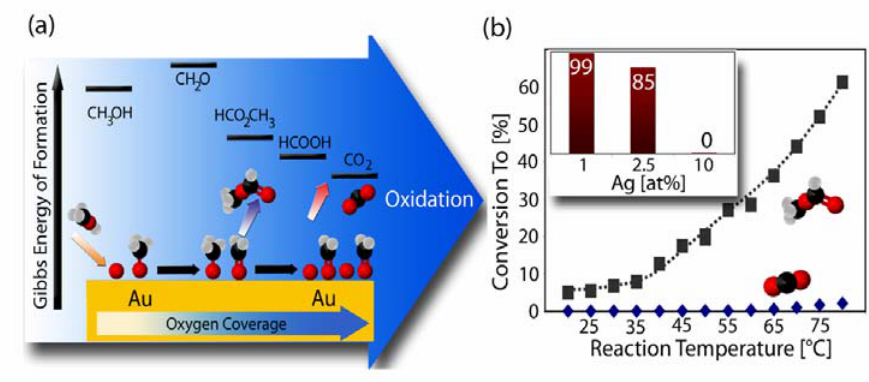
Figure 5. (a) Thermodynamics of oxidation of methanol. Total oxidation to CO thermodynamically favored, and selectivity thus requires desorption of desired intermediates prior to further oxidation. (b) Conversion of methanol to methyl formate (grey squares) and CO (blue diamonds) as a function of the reactor temperature (2 vol % 2 methanol + 1 vol % O ). Inset: The selectivity (percent) towards partial oxidation (methyl 2 formate at 80 °C) depends on the amount of residual Ag in np-Au. Reproduced from Ref.